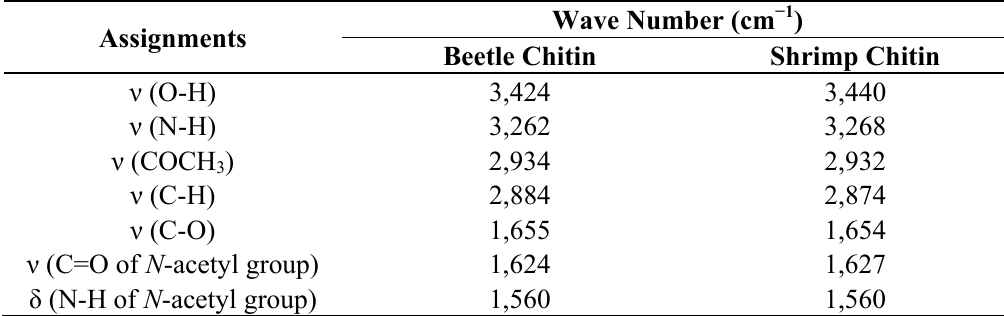
Table 2. Assignments of the relevant bands of IR spectra of chitin from shrimp and adult H. parallela .